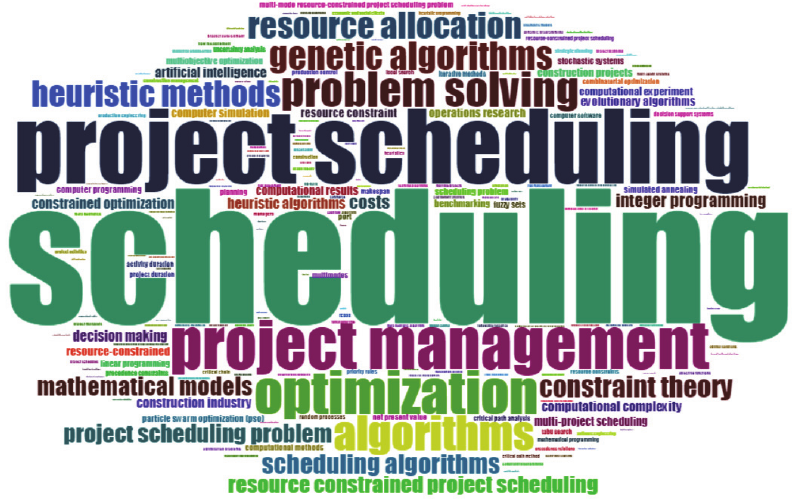
Fig. 4. The frequency of the keywords used in different project scheduling studies